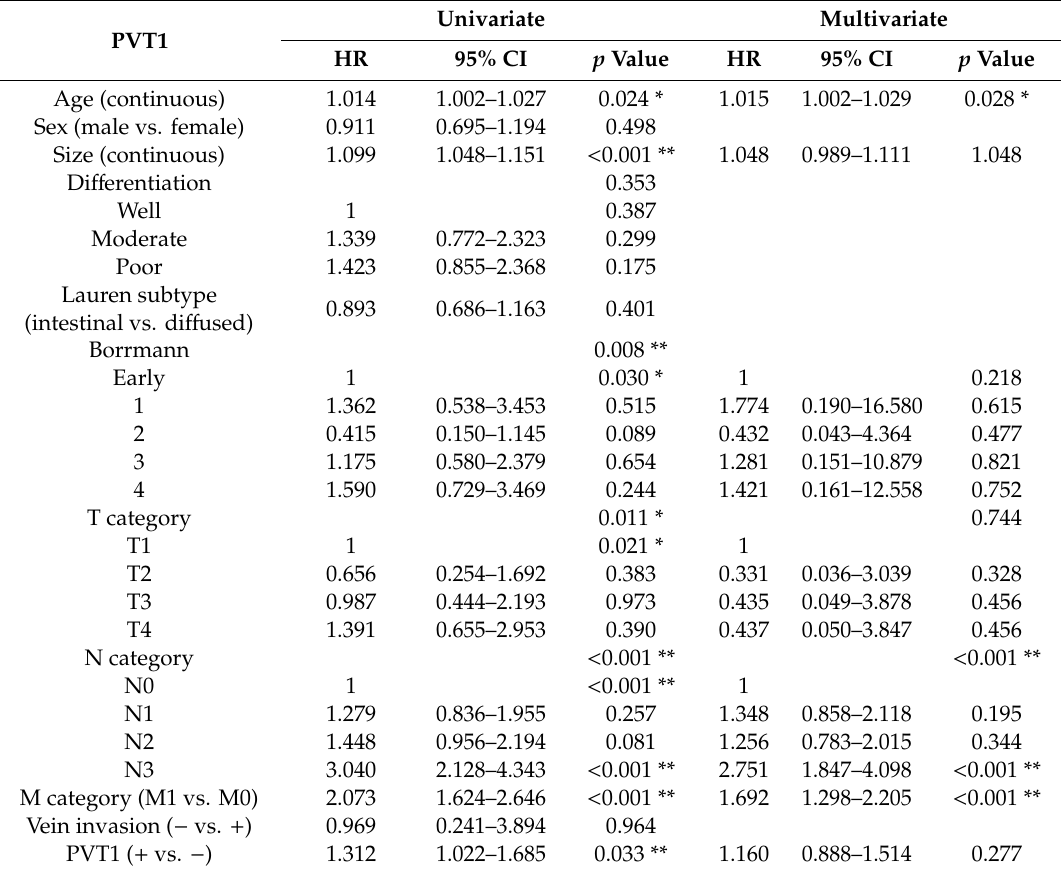
Table 2. Univariate and multivariate Cox regression